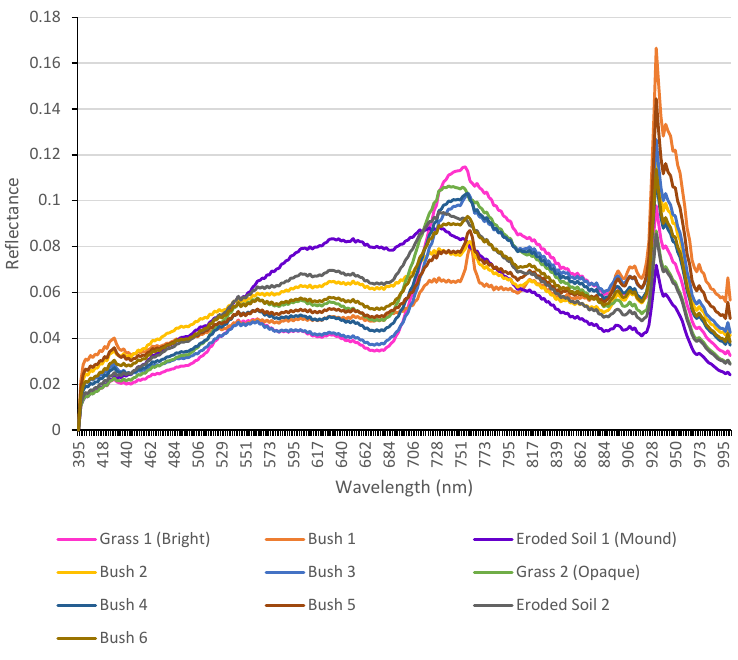
Figure 7. Clustered reflectance spectra of 10 materials from the demonstrative